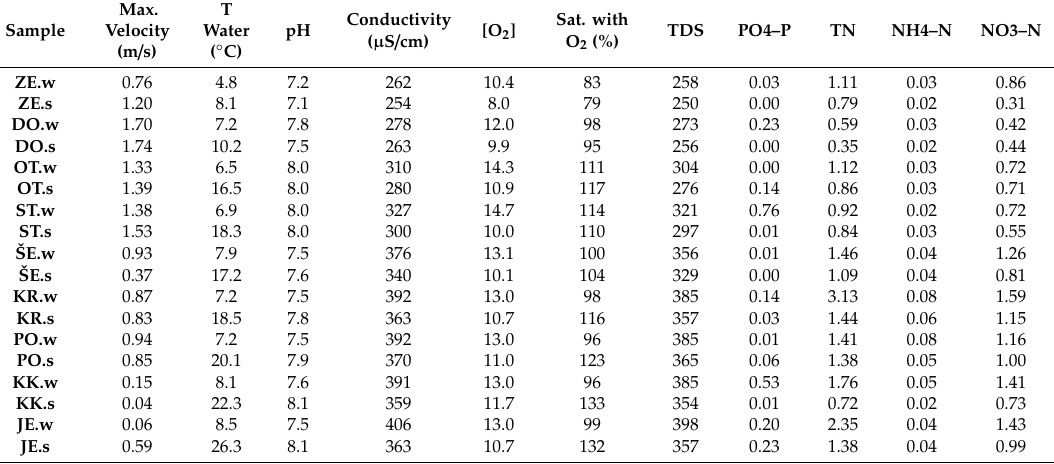
Table A1. Physical and chemical characteristics of water at sampling sites. All concentrations are in mg per